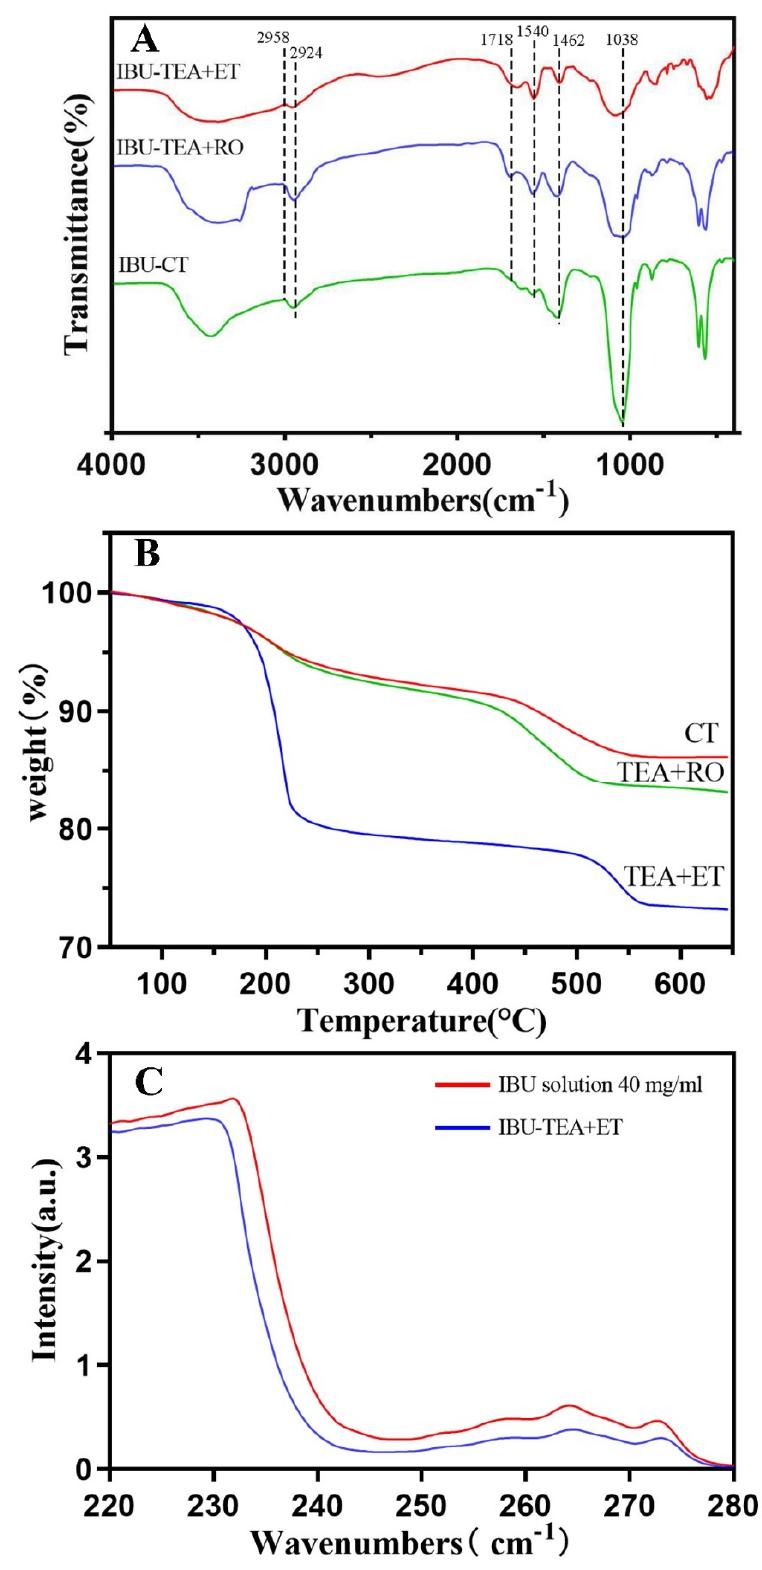
Figure 4. ( A ) FTIR spectra of HAP after IBU loading. ( B ) TG curves of HAP after IBU loading. ( C ) Ultraviolet absorption curve of HAP before and after IBU loading.